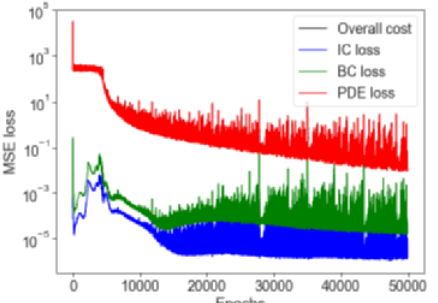
Fig. 1. Convergence of the 3 terms in the loss function. A decrease for the PDE loss can be seen at 5,000 epochs, followed by a smooth convergence of the loss.